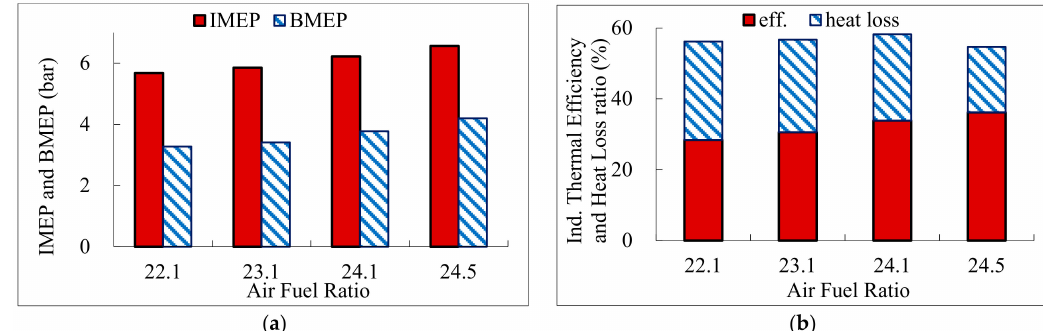
Figure 2. The influence of AFR on engine output and efficiency: ( a ) IMEP and brake mean effective pressure (BMEP); and ( b ) indicated thermal efficiency and heat loss